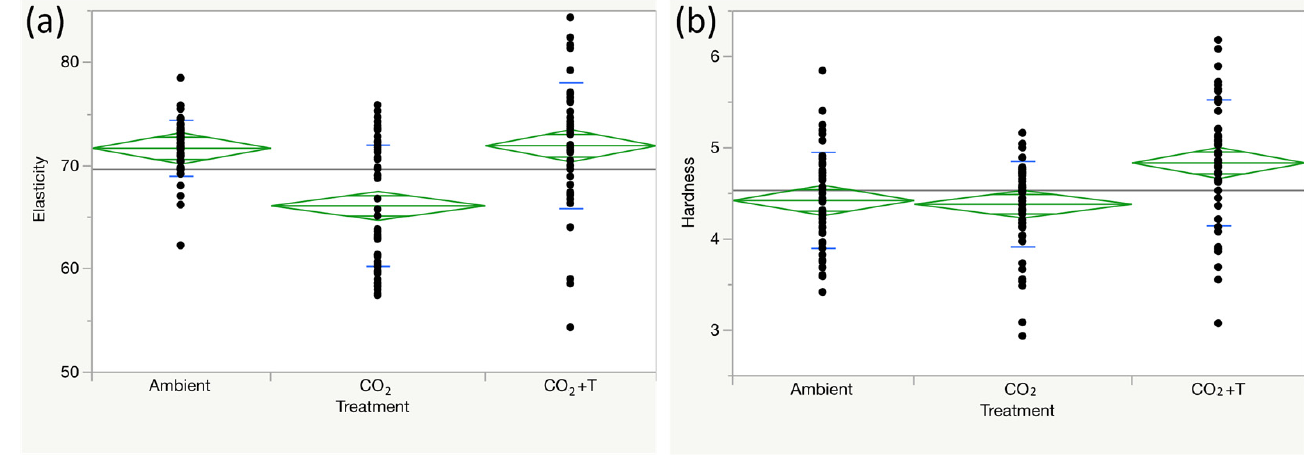
Figure 4. Statistical analyses (one-way analysis of variance) of indentation data for Desmophyllum per-